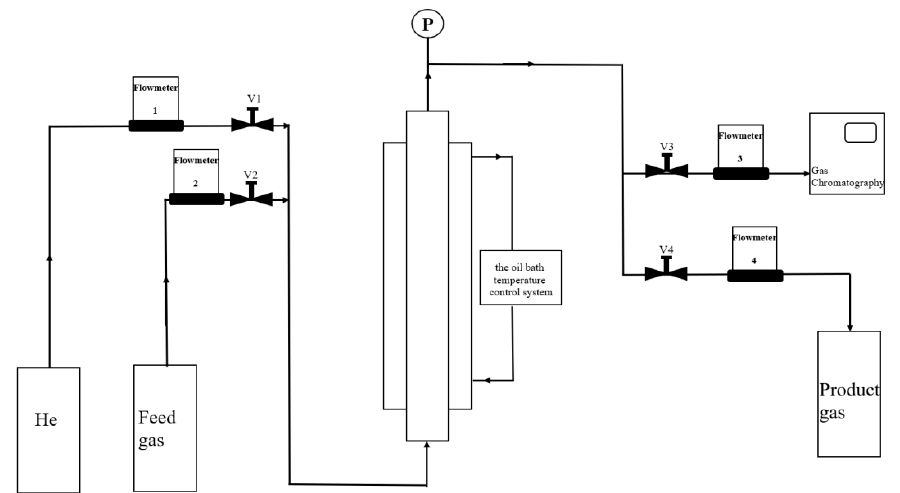
Figure 1. Schematic diagram of the kinetic experimental device for the separation experiments.